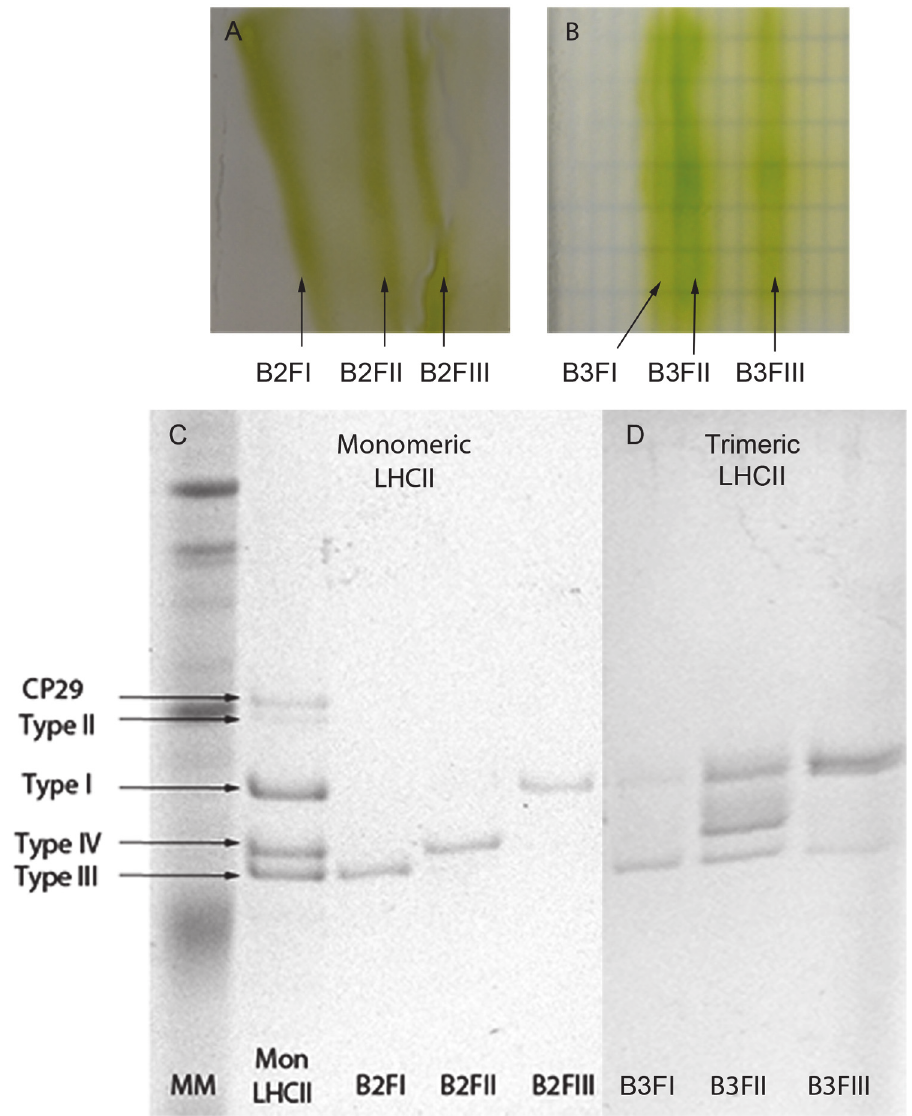
Molecular Marker; Mon LHCII: Monomeric LHCII isolated from a sucrose gradient purification. B2FI, B2FII, B2FIII: Different fractions from the LHCII monomer. B3FI, B3FII, B3III: Different fractions from the LHCII